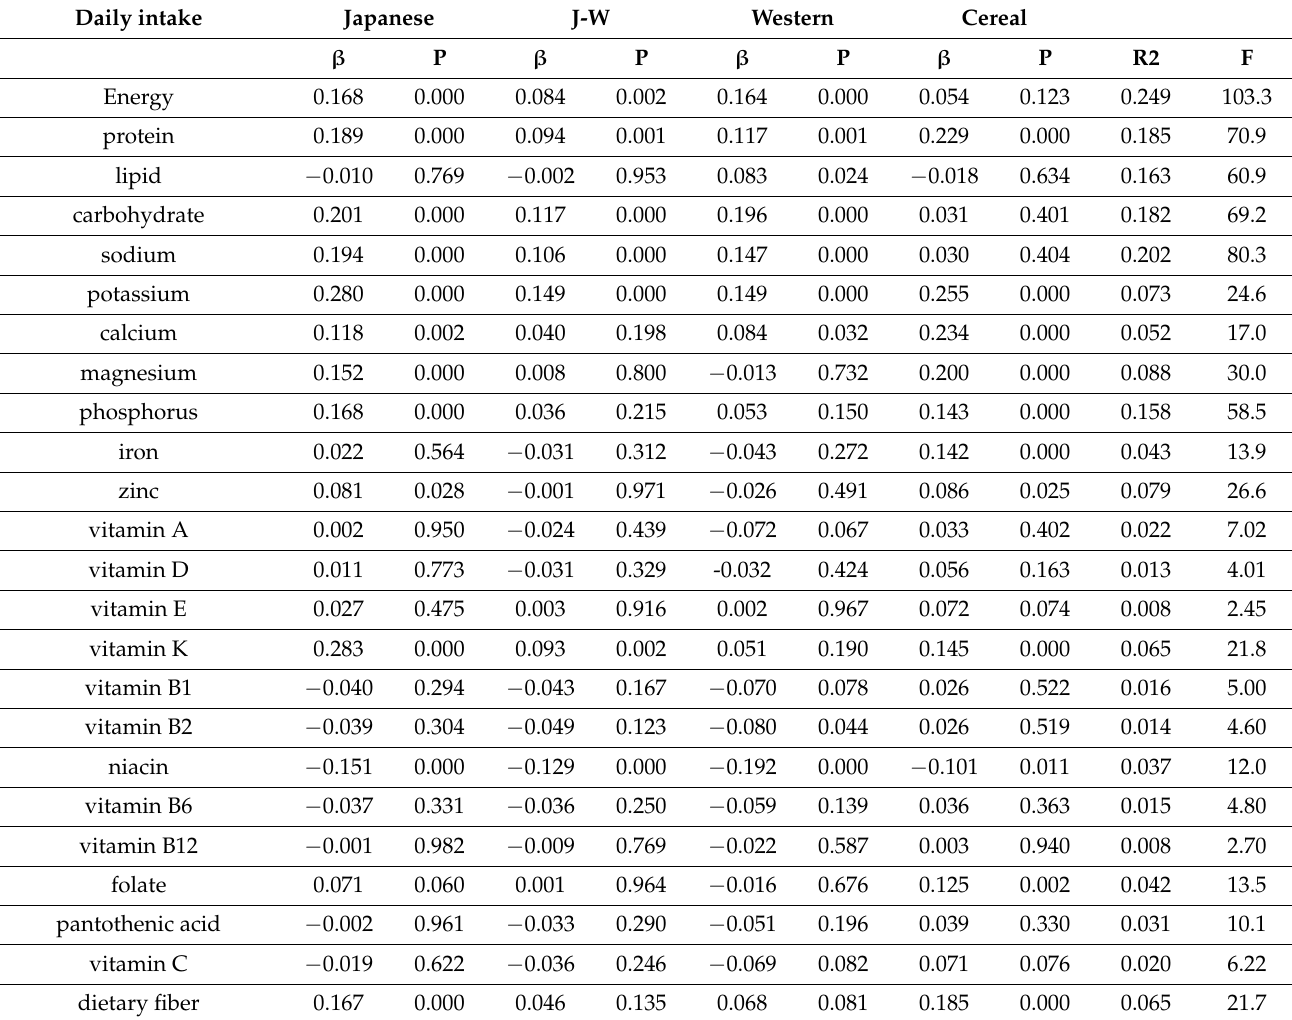
Table 5. Multivariate linear regression analysis for interaction between breakfast meal style and nutrients at daily